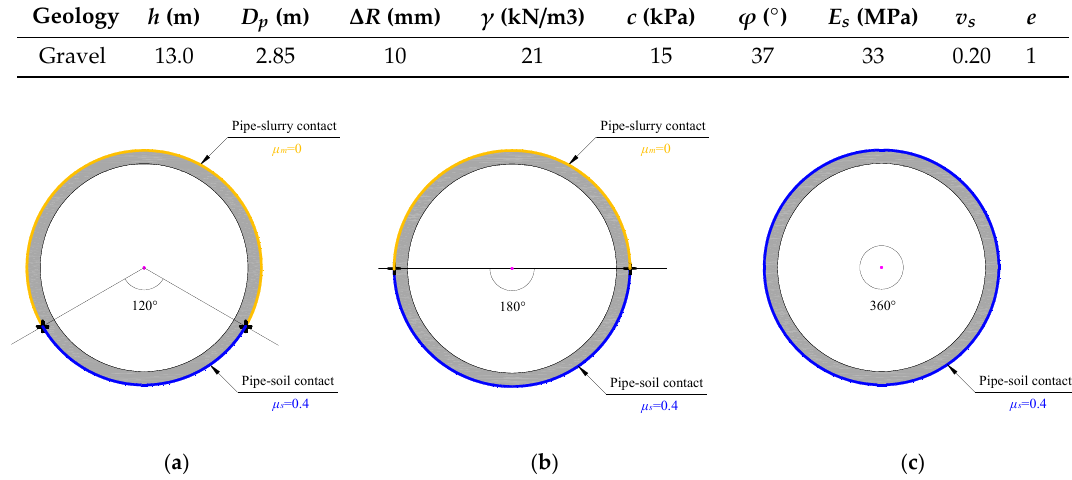
Figure 7. The setting of pipe-soil contact range and frictional coefficient in the numerical simulation. ( a ) 1/3 of the pipe-soil contact; ( b ) 1/2 of the pipe-soil contact; ( c ) 1 of the pipe-soil contact.